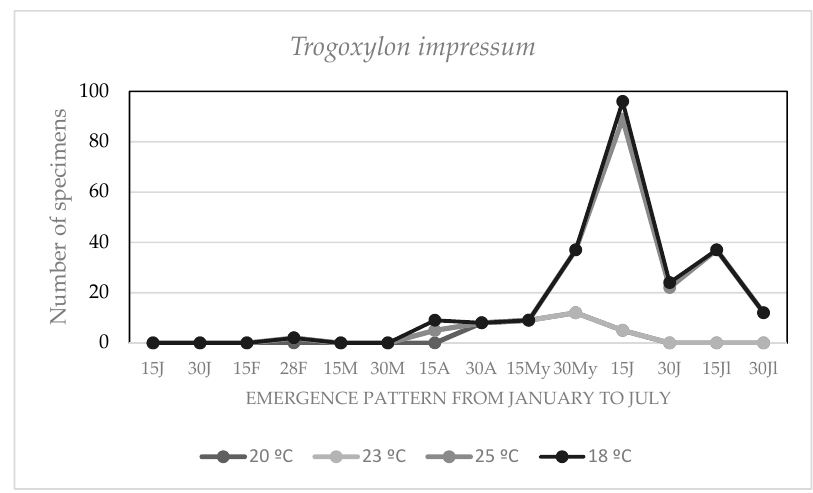
Figure 3. Emergence pattern of Synoxylon sexdentatum at different temperatures “°C” from January to July.